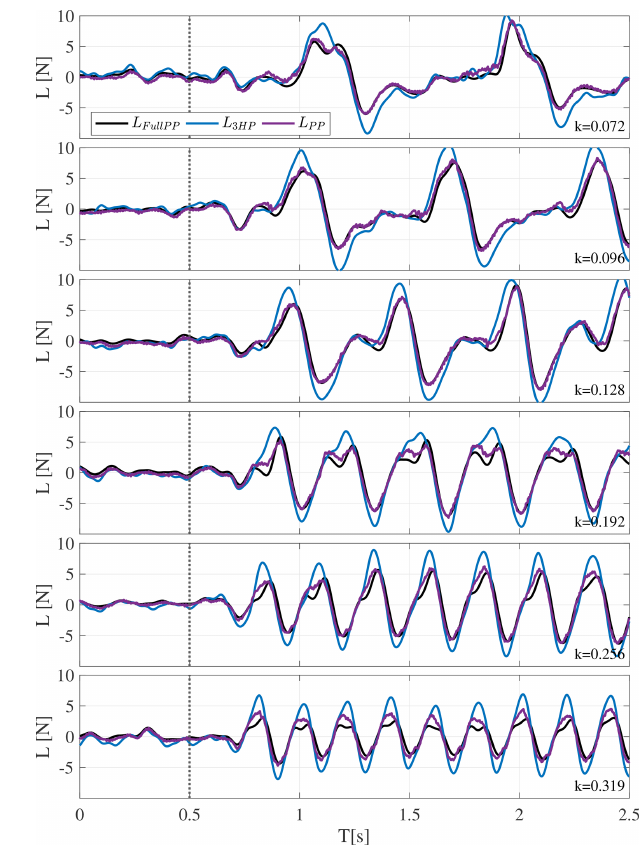
Figure 17. Comparison of the lift estimate to full pressure distribu- tion at ¯ α = 5 ◦ . Active flap.